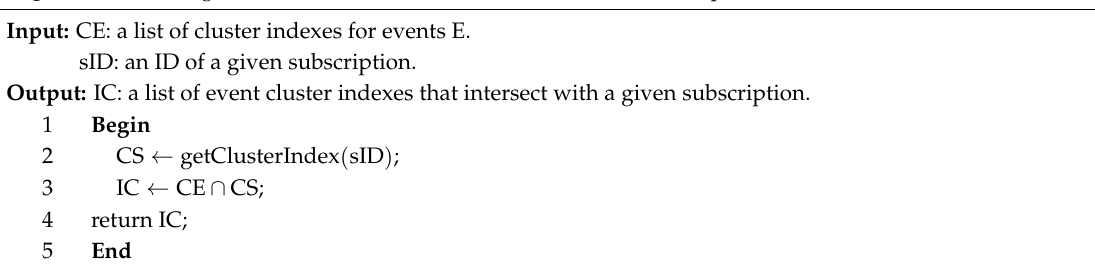
Algorithm 2 Finding Event Clusters that Intersect with a Given